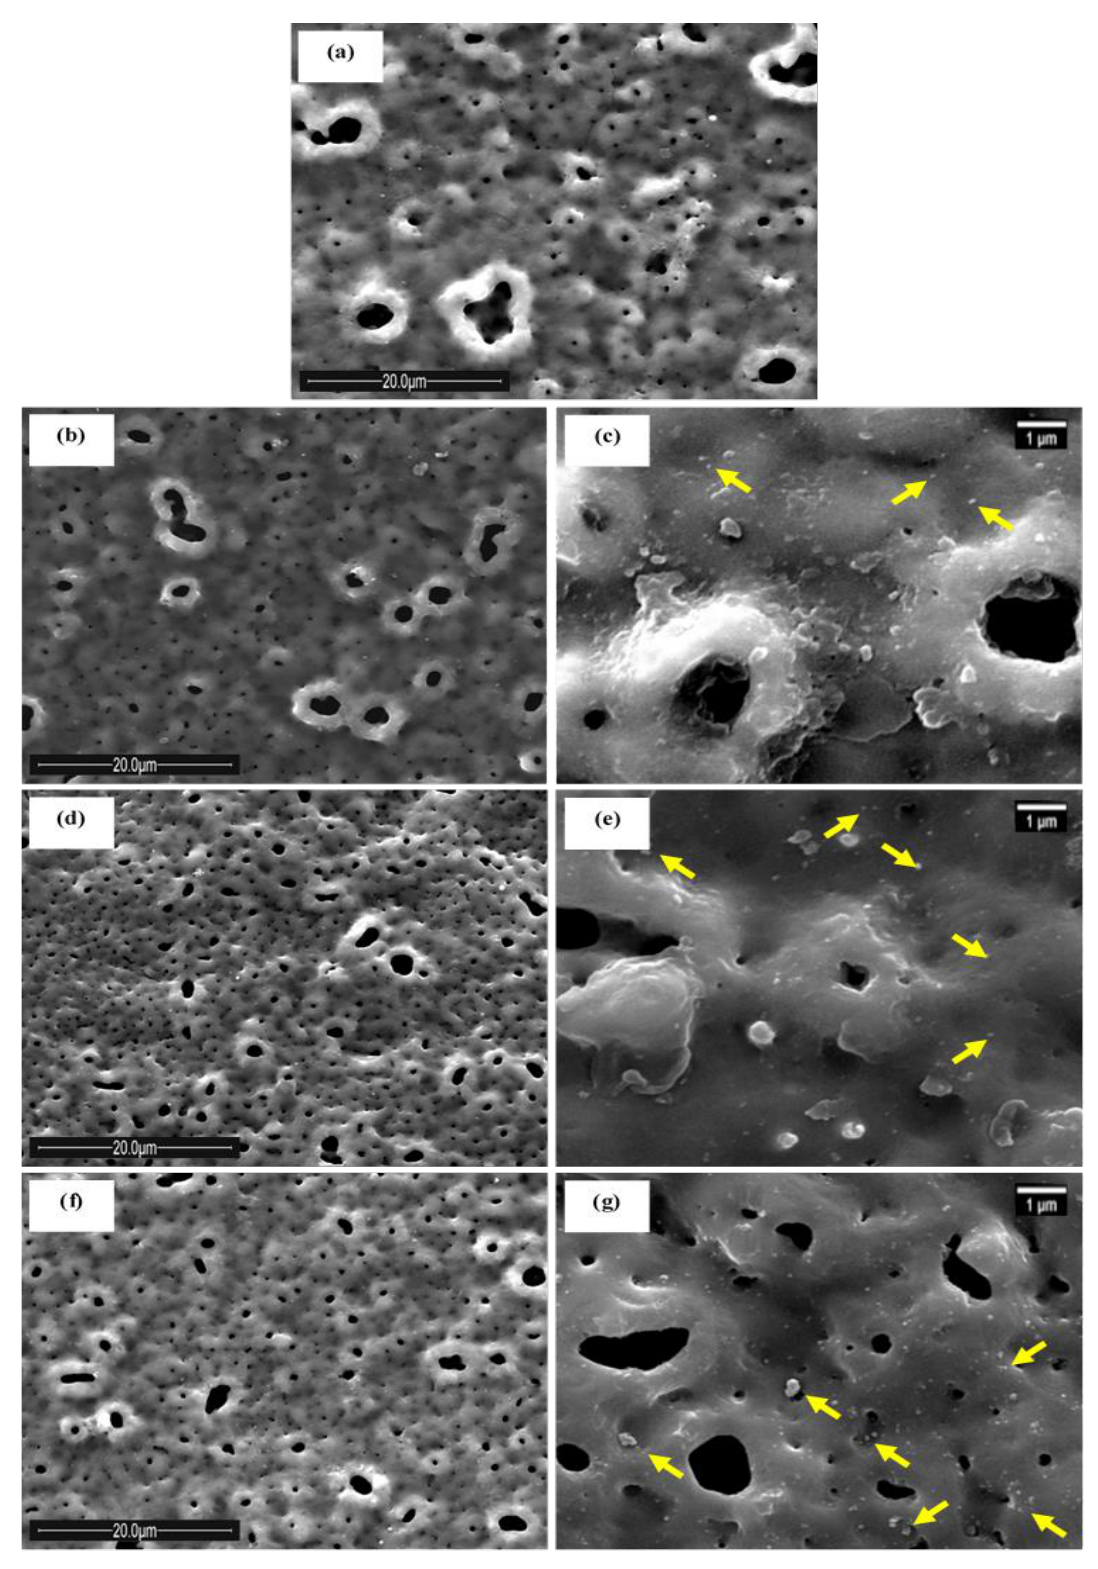
Figure 2. The surface morphologies of the PEO coatings ( a ) without and with ( b , c ) 1 g/L, ( d , e ) 3 g/L, and ( f , g ) 5 g/L of anatase TiO 2 nanoparticles at low and high magnifications (5000 × and 20,000 × , respectively). Table 3. The average pore size, porosity percentage, surface roughness, and thickness values of the PEO coatings without and with different concentrations of anatase TiO 2 nanoparticles.